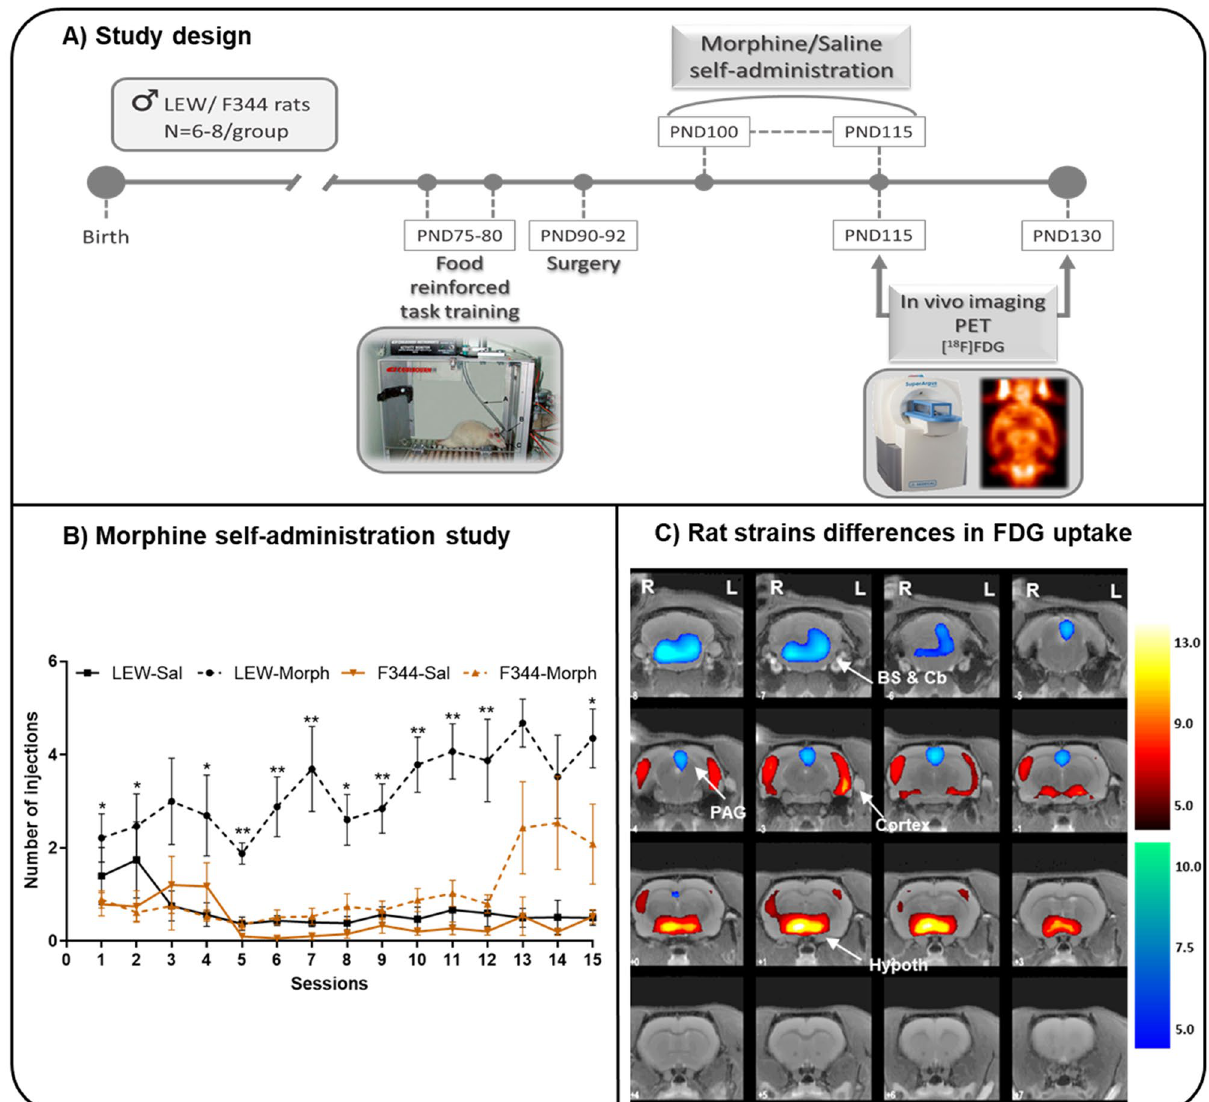
Figure 1. Study design, behavioral study and differences in brain glucose metabolism between rat strains. (A) Representative diagram of the chronology of the experimental procedures performed during the study according to the age of the animals. Abbrev.: 18 FDG, [18F]-Fluorodeoxyglucose; PET, positron emission tomography. (B) MSA study in LEW and F344 rats. Morphine (1 mg/kg) or saline self-administration in adult LEW and F344 rats under an FR1 schedule of reinforcement. The values are expressed as the mean ± SEM: LEW-saline (n = 6), LEW-morphine (n = 8), F344-saline (n = 6), and F344-morphine (n = 7). The number of morphine injections per session was greater for LEW animals than for F344 animals. 3-way ANOVA